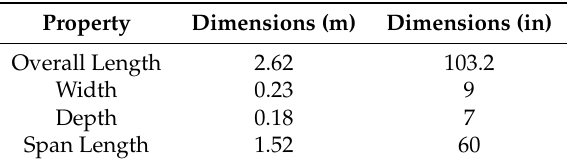
Table 2. Finite Element Analysis model